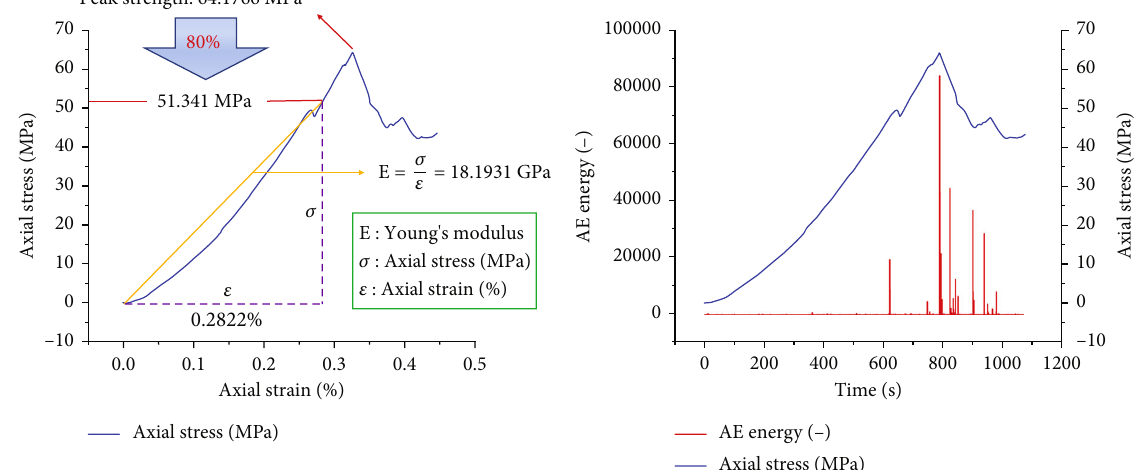
Figure 4: Mechanical experimental e ff ect of preexisting fractures on the initial reference value as